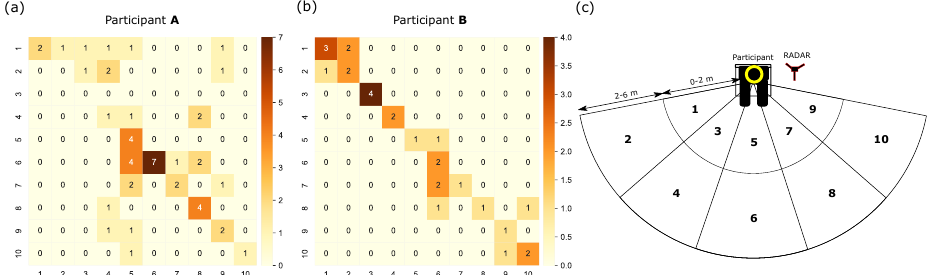
Figure 4. ( a , b ) The confusion matrices of a single person moving in the scene through locations 1–10 for deafblind participant A and B. ( c ) A schematic of our experimental setup during the workshop with locations 1–10